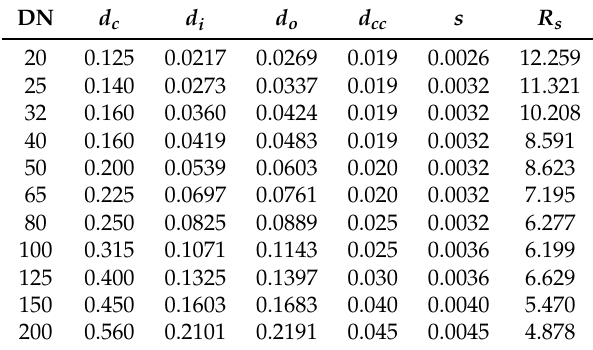
Table A2. Dimensions of twin pipes and resulting symmetrical thermal resistance. All distances are expressed in m, the thermal resistance per unit length R in Km/W. All data has been retrieved from Isoplus catalogues [33].